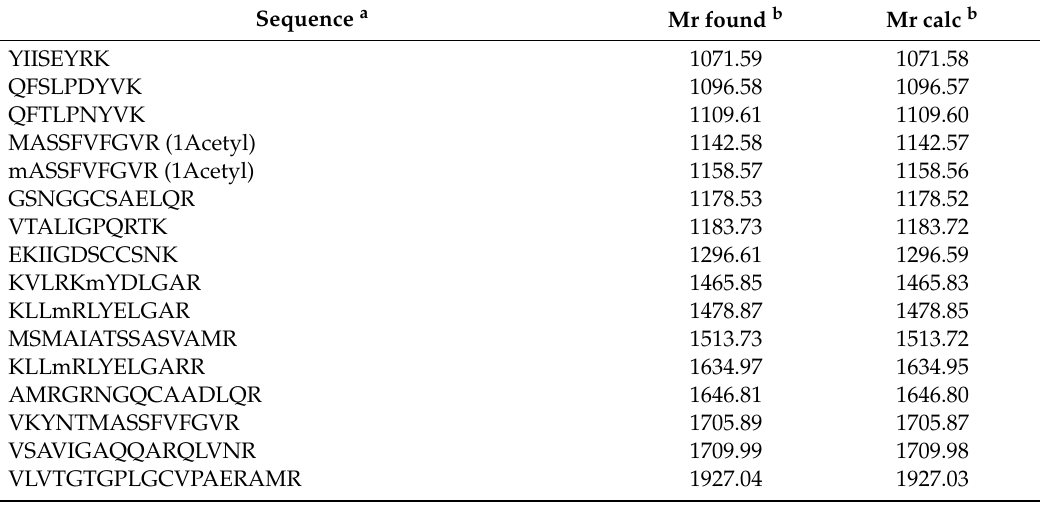
Table 2. MS / MS identified peptides from GDSL esterase family by trypsin digestion. Sequence